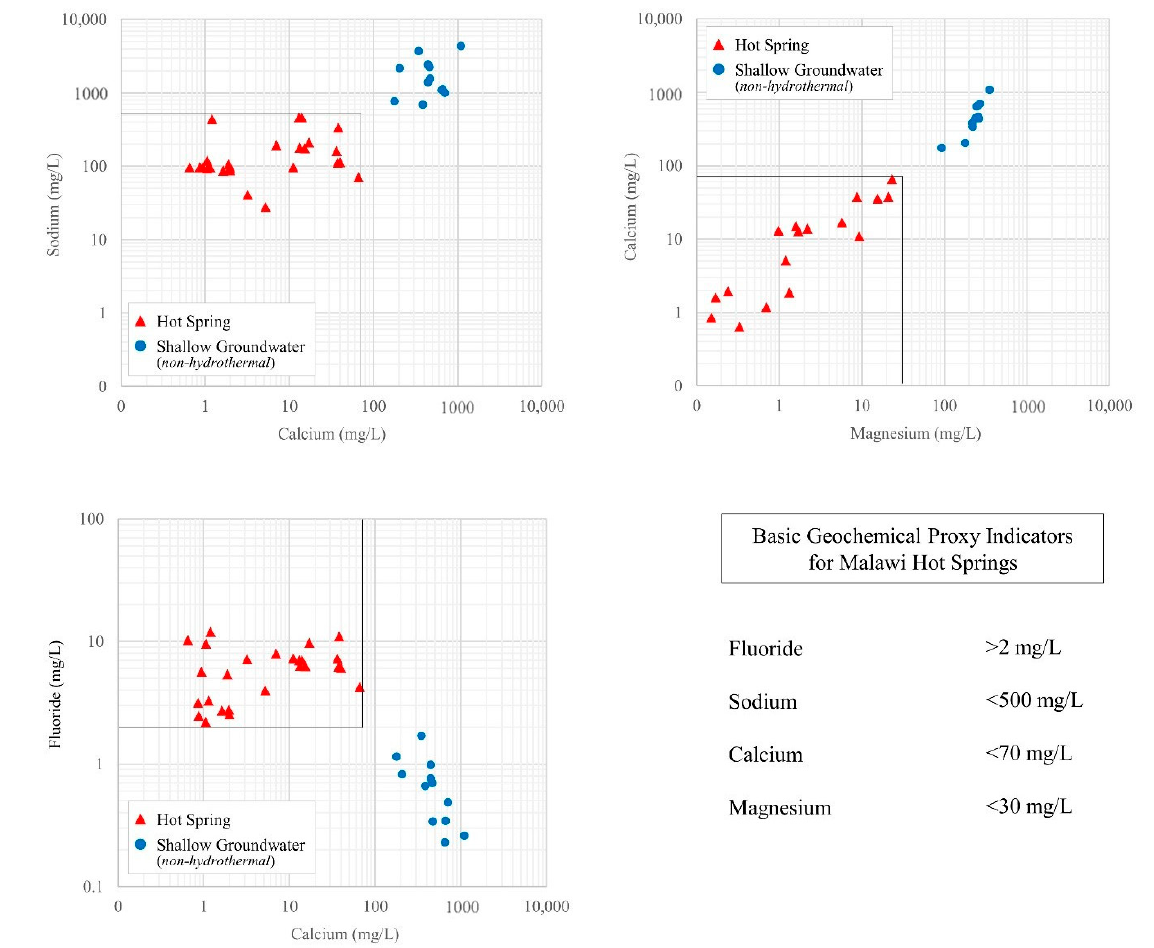
Figure 4. Basic geochemical proxy indicators for hot spring activity, identified from the model data, collected directly from hot springs and supply boreholes within the Malawi Rift Valley. All shallow groundwater samples were non-hydrothermal and occurred within rift basin sediments.